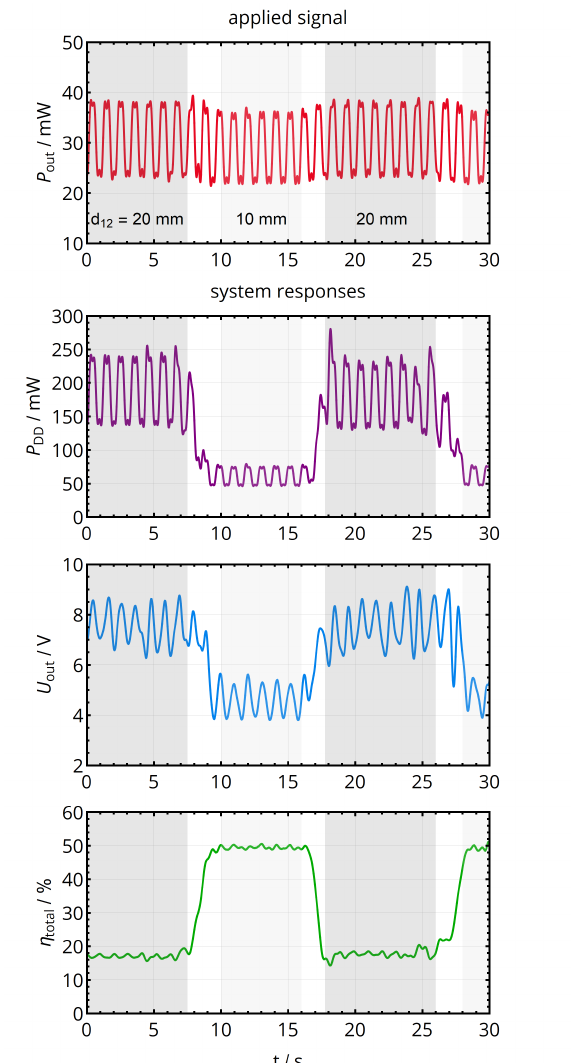
Figure 16. Reaction of the complete power feedback and maximum efficiency point tracking system with respect to a change in load power consumption (every 500ms) and a change in coil separation distance (changing between 10mm and 20mm approximately every 10s). The signals were low-pass filtered to show the time-averaged behavior without the individual switching events of the controllers. Both load and coil distance changes are automatically